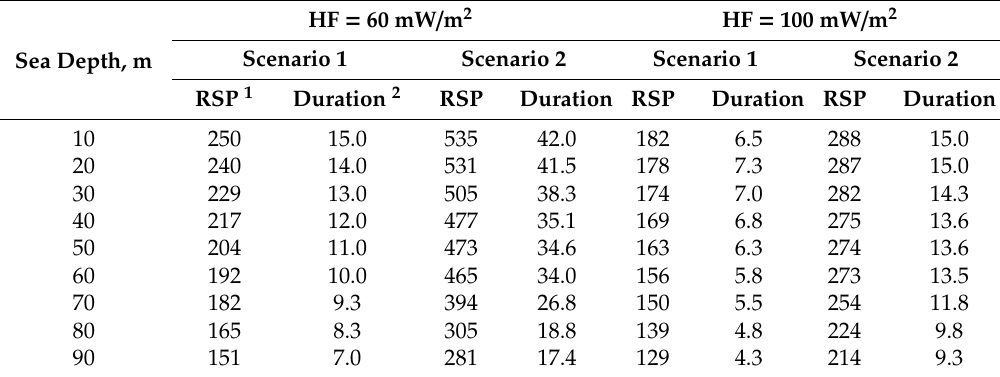
Table 3. Simulation